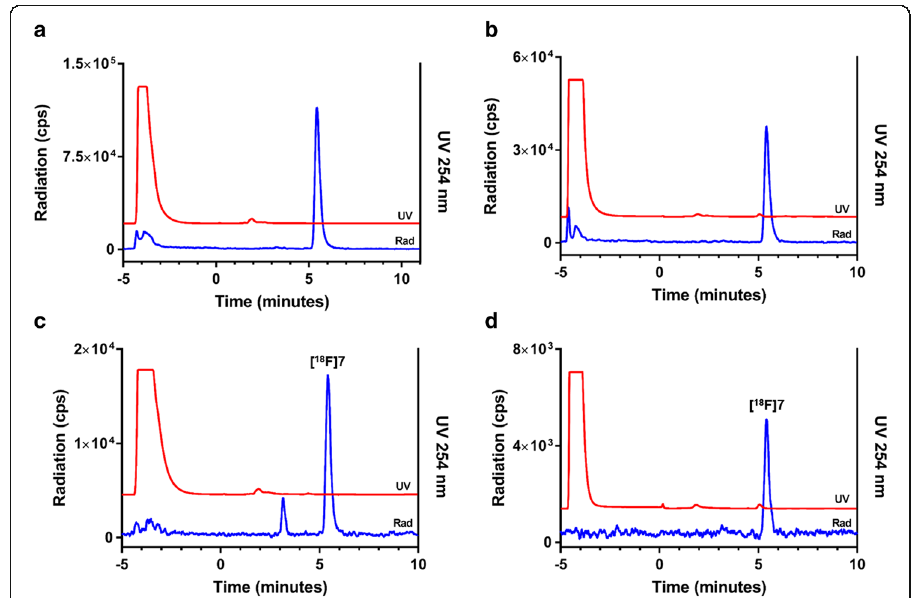
Fig. 4 Representative column-switching HPLC radio-metabolite analysis of controls and experimental samples. Column-switching from capture-column loading to elution of the capture column onto the analytical column starts at t =0min. Radioactivity (blue) and UV (254nm, red) spectra are shown overlaid. ( a ) Control sample plasma spiked with [ 18 F]7 ; ( b ) control sample pancreas spiked with [ 18 F]7 ; ( c ) 60-min post-injection in plasma; ( d ) 60-min post-injection in the